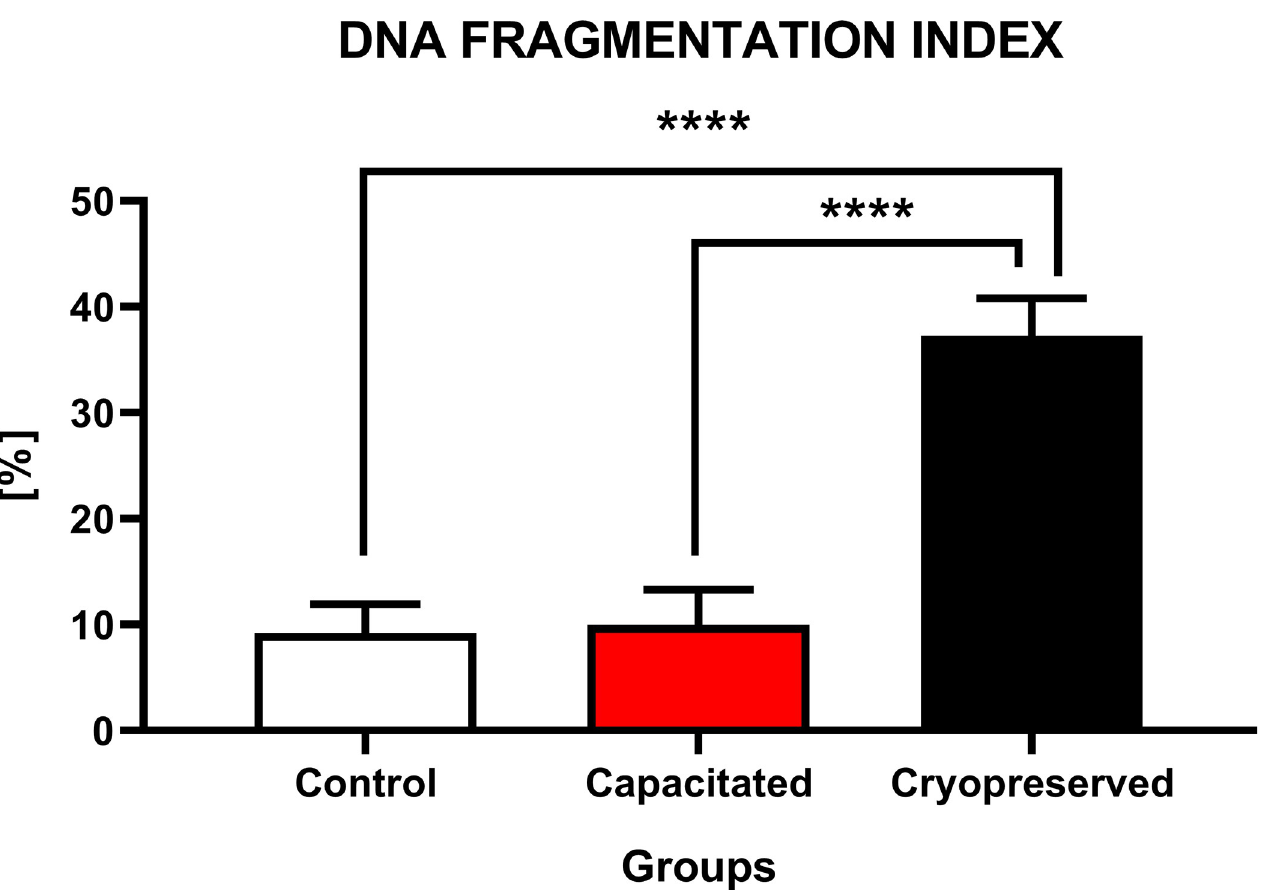
Fig 8. DNA fragmentation index of non-capacitated, in vitro capacitated and cryopreserved bovine spermatozoa. The values in the columns represented the percentage (%) of spermatozoa with fragmented DNA between the groups ( ± SD). The level of significance was set at � P < 0.05; �� P < 0.01; ��� P < 0.001; ���� P <